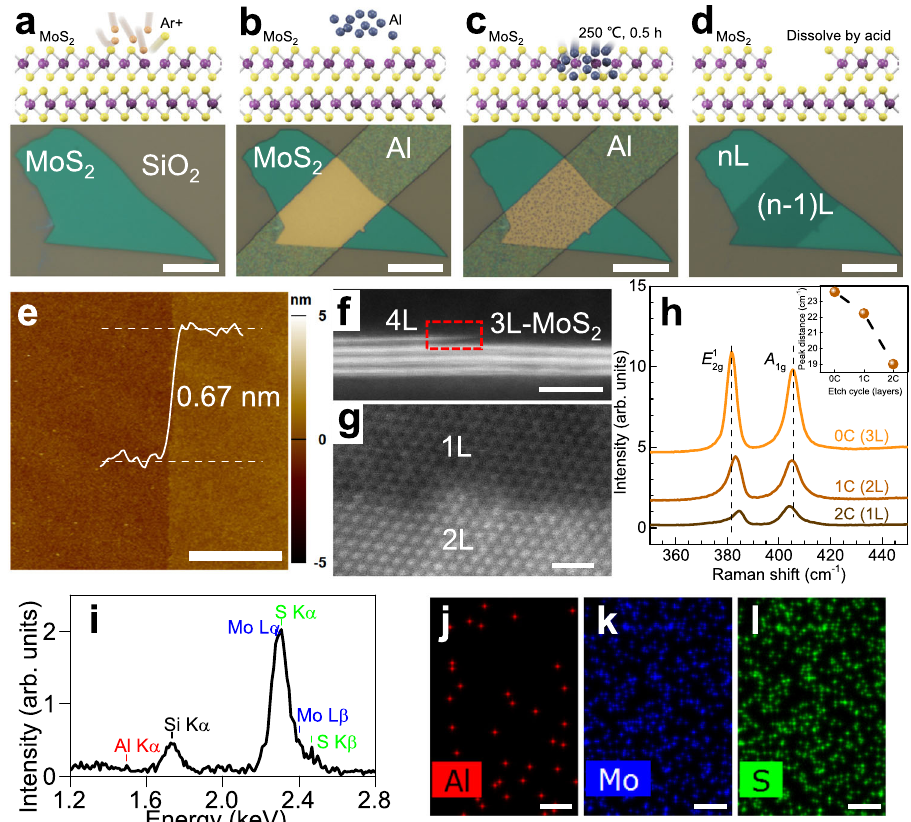
Fig. 2 Non-invasive digital etching technique and corresponding characterization. a – d Schematic processing fl ow for the controllable digital etching. Scale bar: 10 μ m. a Controlled Ar plasma irradiation to produce uniformly distributed sulfur vacancies in the topmost MoS 2 layer. b Local deposition of sacri fi cial metal Al strips on MoS 2 . c Thermal annealing at 250 °C for 0.5 h to facilitate the diffusion of Al into MoS 2 . d Dissolving Al and related alloy by hydrochloric acid. The topmost MoS 2 layer is removed fi nally, where nL denotes the number of layers. Digitally etched monolayer steps (0.67 nm) between the pristine and etched areas as revealed by e AFM, f cross-sectional, and g top-view atomic images. Scale bar in e : 3 μ m. Scale bar in f , g : 2 nm. h Raman spectra for pristine (0C) and etched local MoS 2 areas for one cycle (1C) and two cycles (2C). Inset: Peak distance between the E 1 etching cycles (i.e., number of MoS 2 layers). i Accumulated energy dispersive spectrum from the as-etched monolayer to estimate the content of Al residues. j – l Typical EDS elemental mappings for the Al, Mo, and S elements, respectively. The trace of Al residues is below the instrumental uncertainty of 5%. Scale bars in j – l : 1